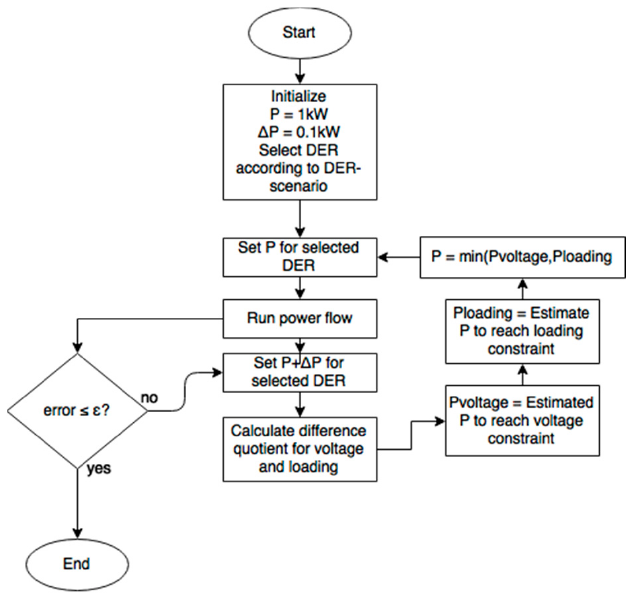
Figure 5. Adapted Newton-Raphson (NR)-optimization.